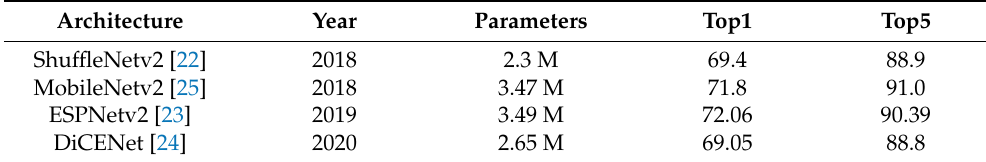
Table 1. Comparison of various lightweight architectures.